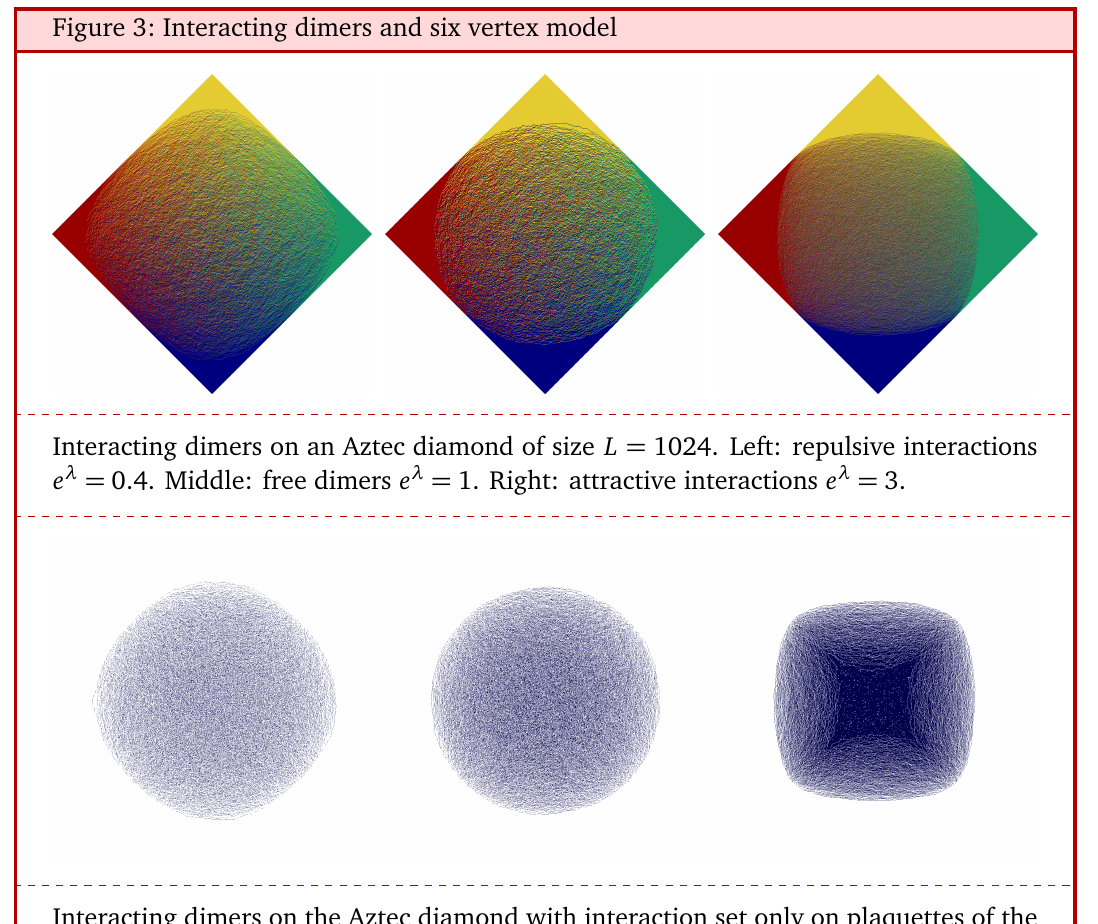
Figure 3: Interacting dimers and six vertex model